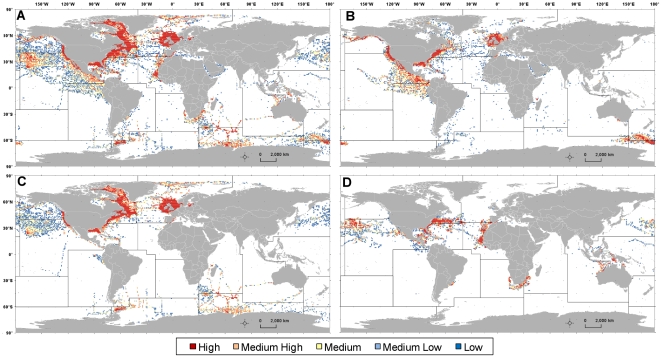
Relative abundance of records per square degree published on SEAMAP in 1 degree square cells.Abundance for: (A) all marine mammals, seabirds, and sea turtles; (B) marine mammals; (C) seabirds; and (D) sea turtles. Each color represents one quintile (hot to cool colors: red, orange, yellow, light blue, and dark blue), containing the number of records that fell into the >79th (high), 79-60th (medium-high), 59-40th (medium), 39-20th (medium-low), and <20th (low) percentiles, respectively.